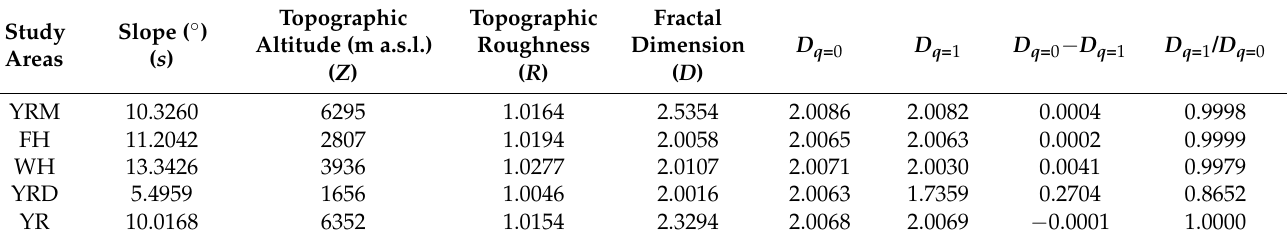
Table 3. Common topographic parameters and extra multifractal